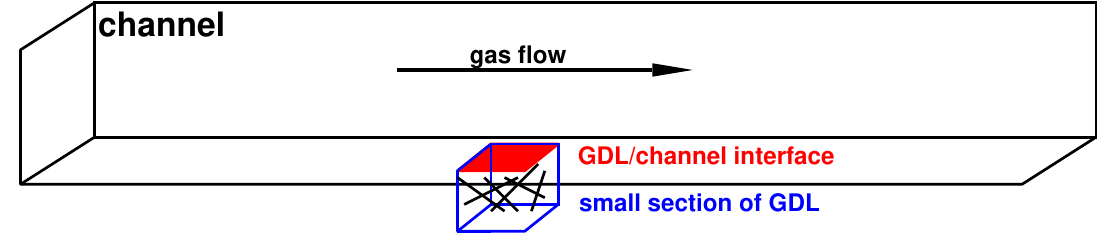
Figure 1. Gas diffusion layer (GDL)/channel interface as a connecting area between multiple